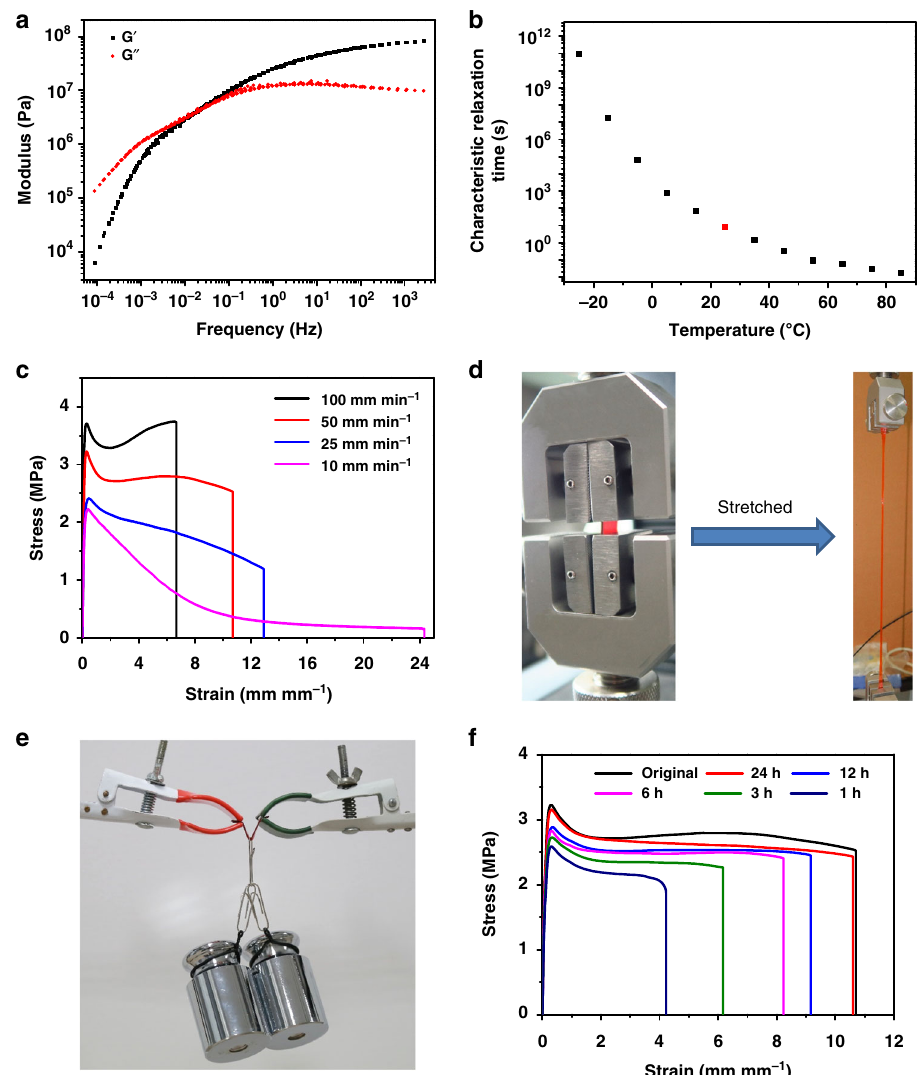
Fig. 2 Mechanical properties of Zn(Hbimcp) 2 -PDMS polymer. a The time – temperature superposition curve of Zn(Hbimcp) 2 -PDMS polymer at 25 °C. b The characteristic relaxation times of Zn(Hbimcp) 2 -PDMS polymer under different temperature. c The strain – stress test of Zn(Hbimcp) 2 -PDMS polymer under different stretching speed. d Photographs of a fi lm before and after stretching. e Optical image of a fi lm sustaining a 1000 g load. f Strain – stress curves of a fi lm healed at room temperature (25 °C) for different lengths of time show an increase of the stretching ability when the fi lm is allowed to heal for a longer